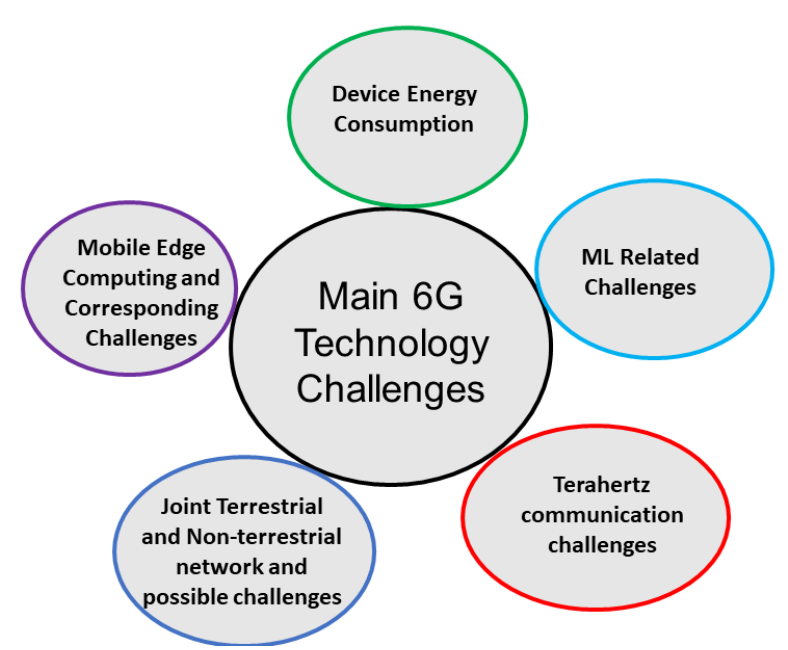
Figure 1. Main applications of distributed